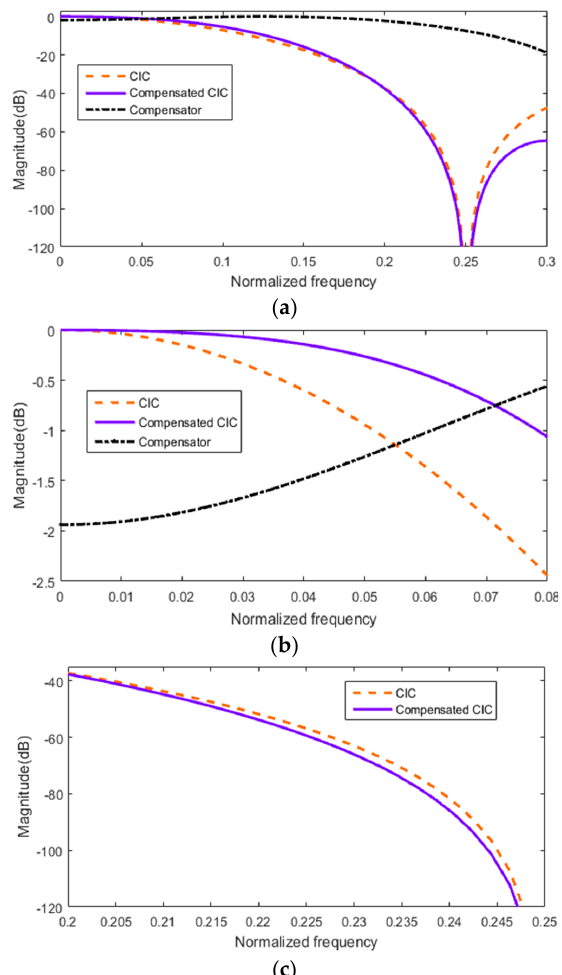
Figure 7. Analysis of CIC compensation. ( a ) Magnitude response of CIC filter before and after compensation; ( b ) pass band characteristics; ( c ) transition band characteristics.